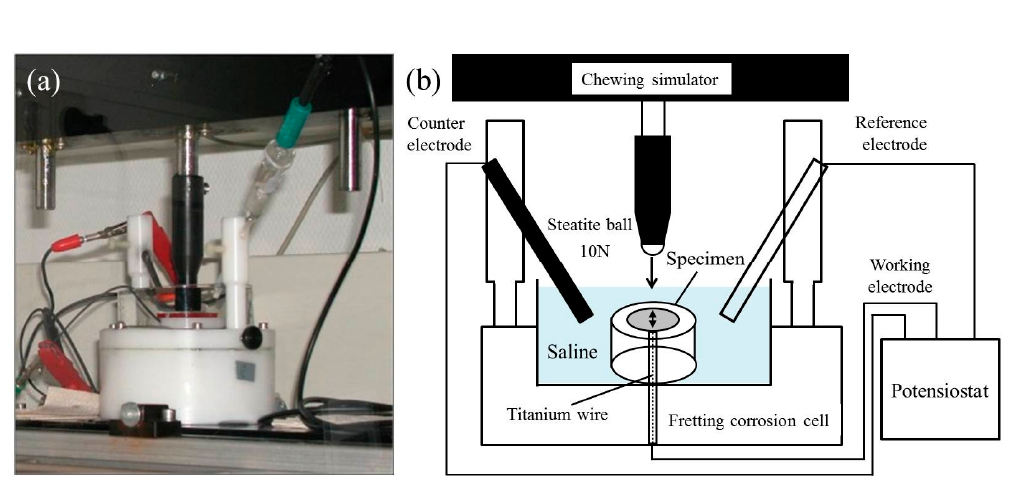
Figure 1. ( a ) Fretting corrosion cell; ( b ) A schematic diagram of the fretting corrosion test.